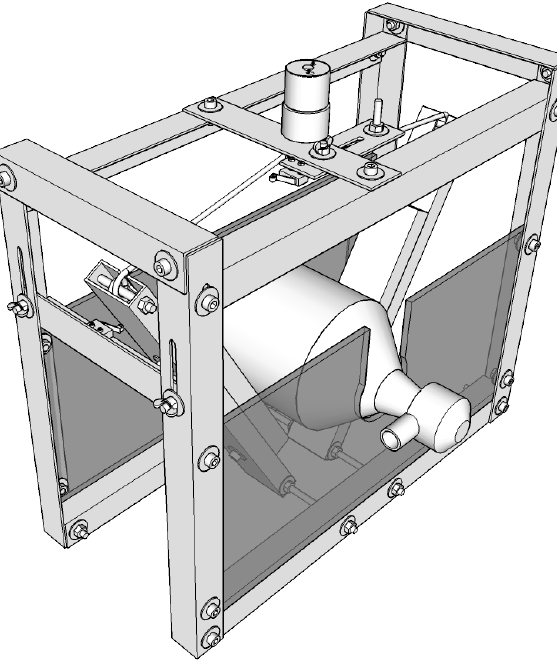
Figure 3. Three-dimensional render of the experimental actuated resuscitator machine (eARM)